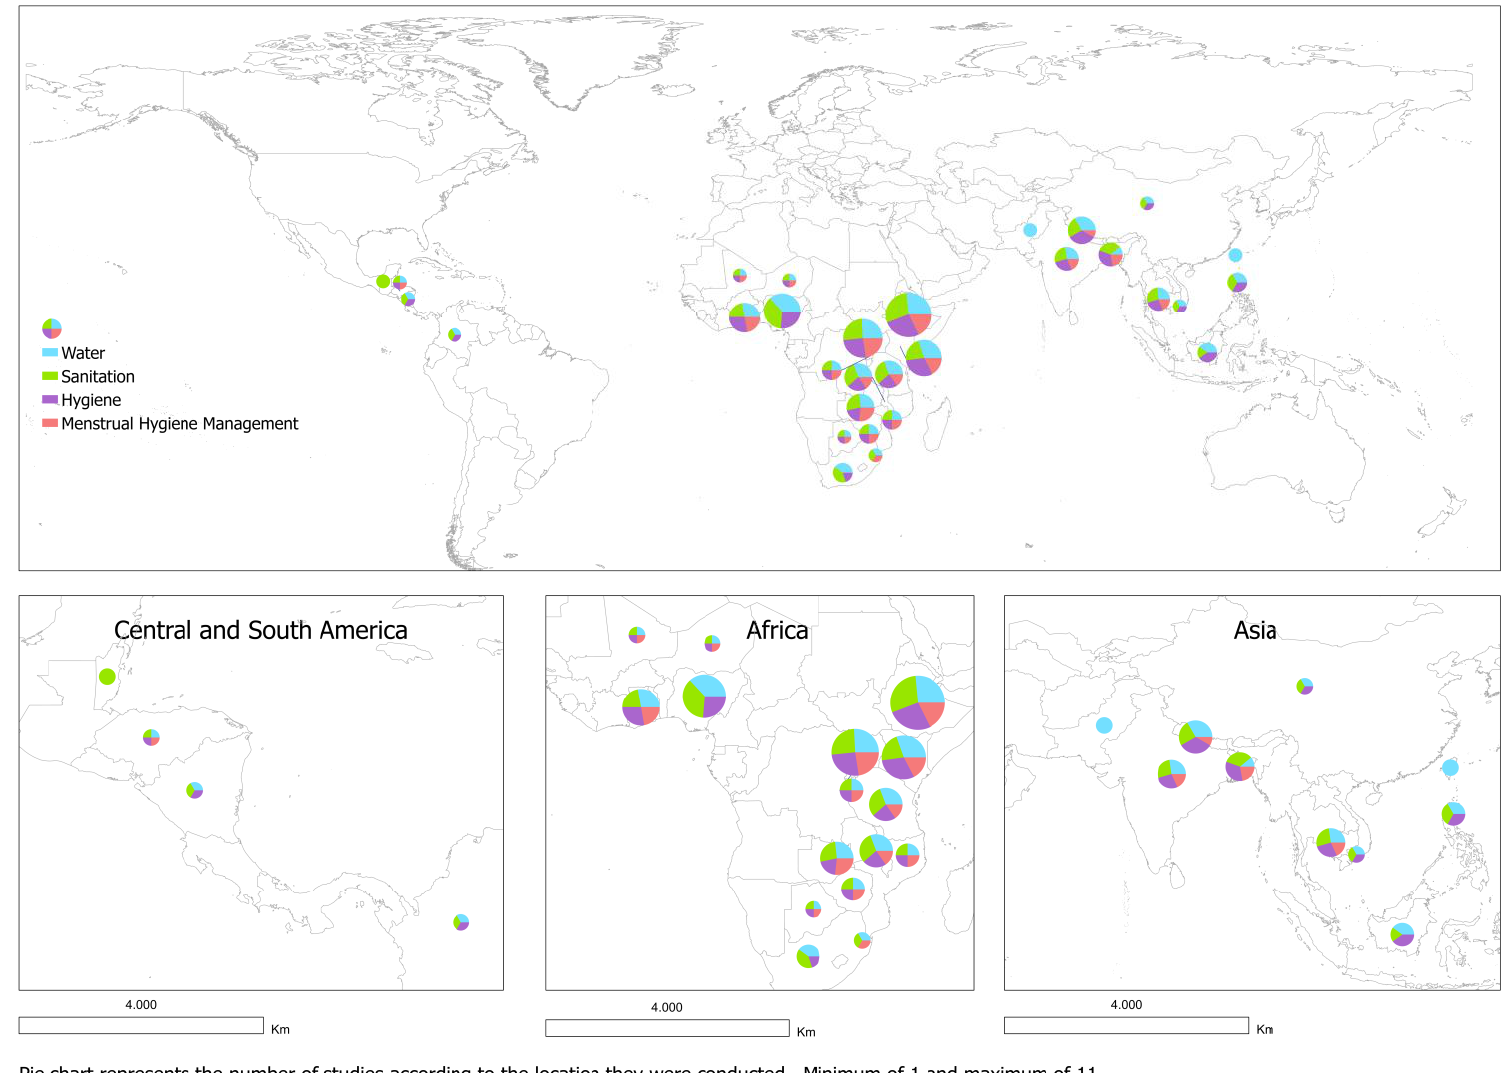
Figure 2. Distribution of the 65 publications included in the systematic review according to the location the studies were conducted.